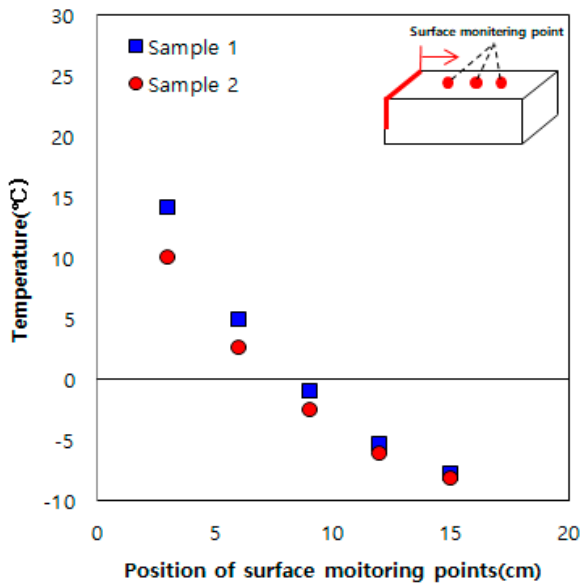
Figure 3. Results obtained using a single heating element.